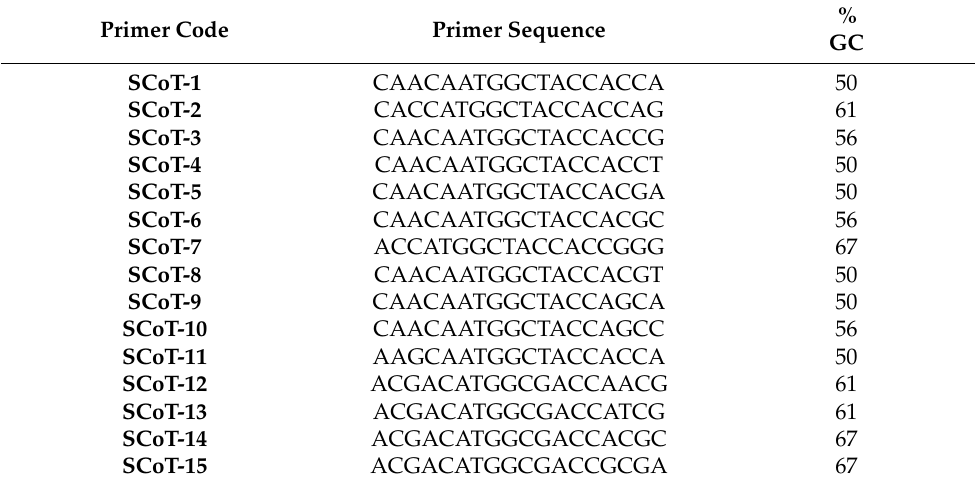
Table 2. SCoT primers code, sequence, and